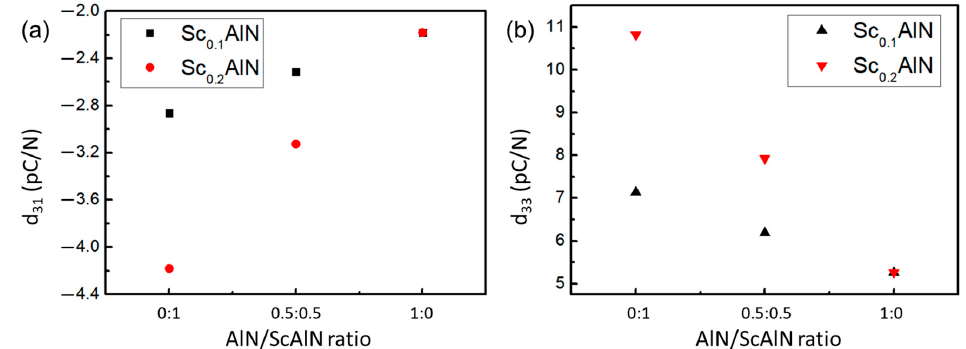
Figure 2. The calculated piezoelectric constant ( a ) d 31 and ( b ) d 33 of AlN and AlN/ScAlN composite films. The value of pure AlN and ScAlN are obtained by first principal calculation and the value of composites are obtained by MT model.